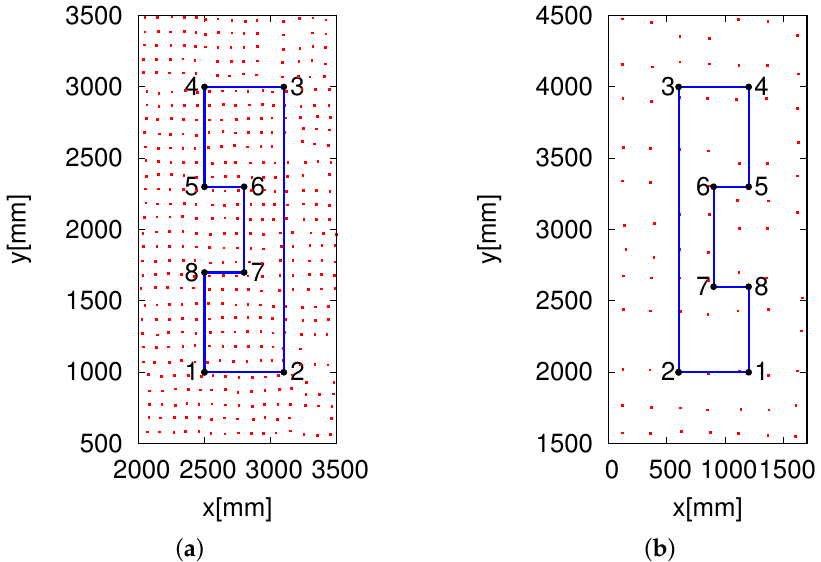
Figure 13. Experimental environment: ( a ) the installation of ID tags with a density of 100 tags/m 2 and ( b ) the installation of ID tags with a density of 16 tags/m 2 . The red dots represent the ID tags, and the blue lines represent the experimental routes. The black dots represent statistic